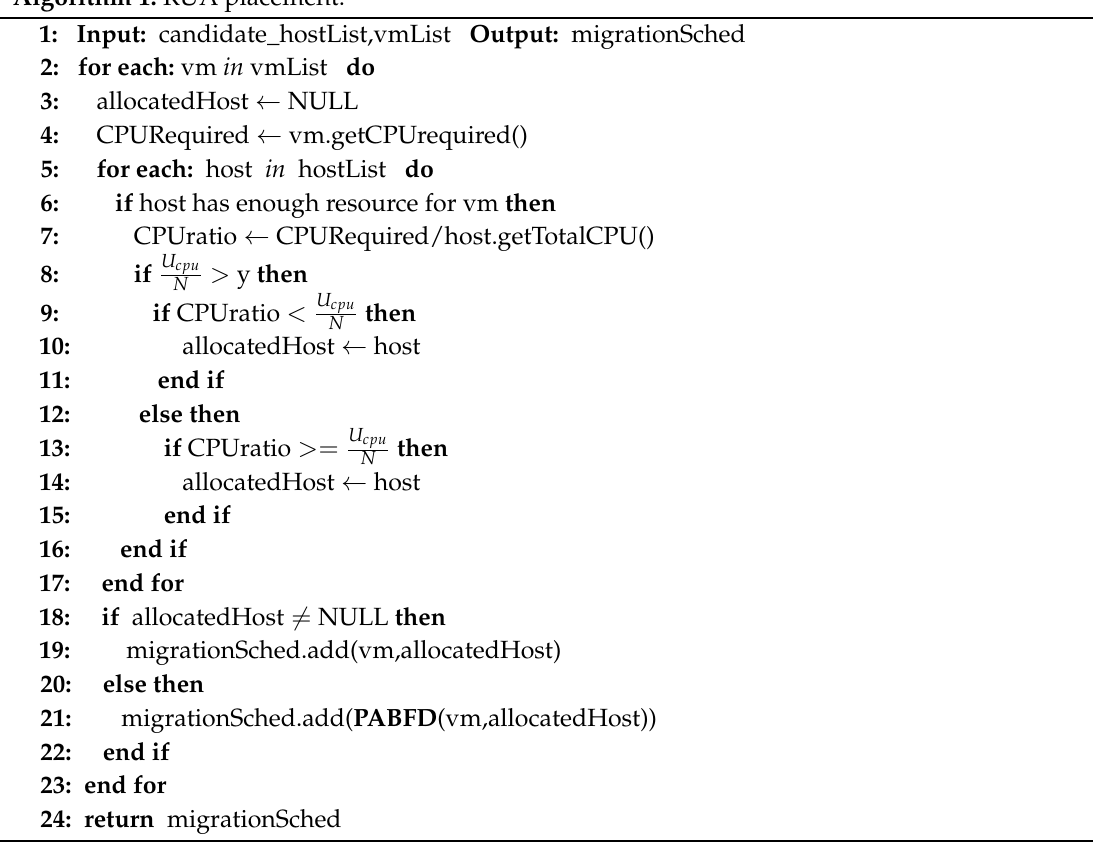
Algorithm 1: RUA placement.